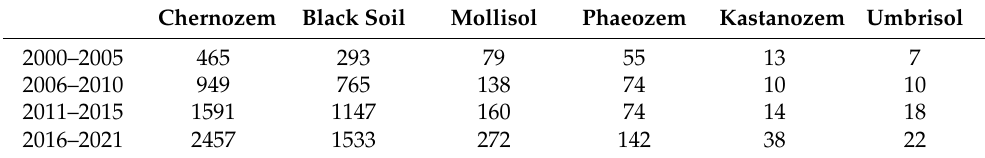
Table 1. Number of posts for six search terms at 5-year intervals. Chernozem Black